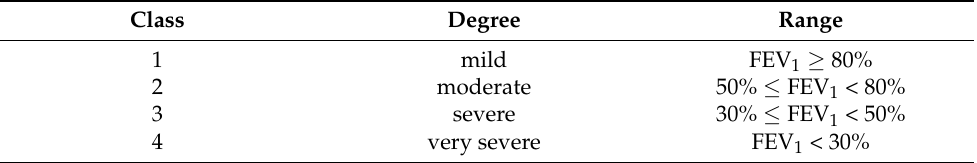
Table 1. Intervals of FEV 1 values according to their severity degree. GOLD classification. Class